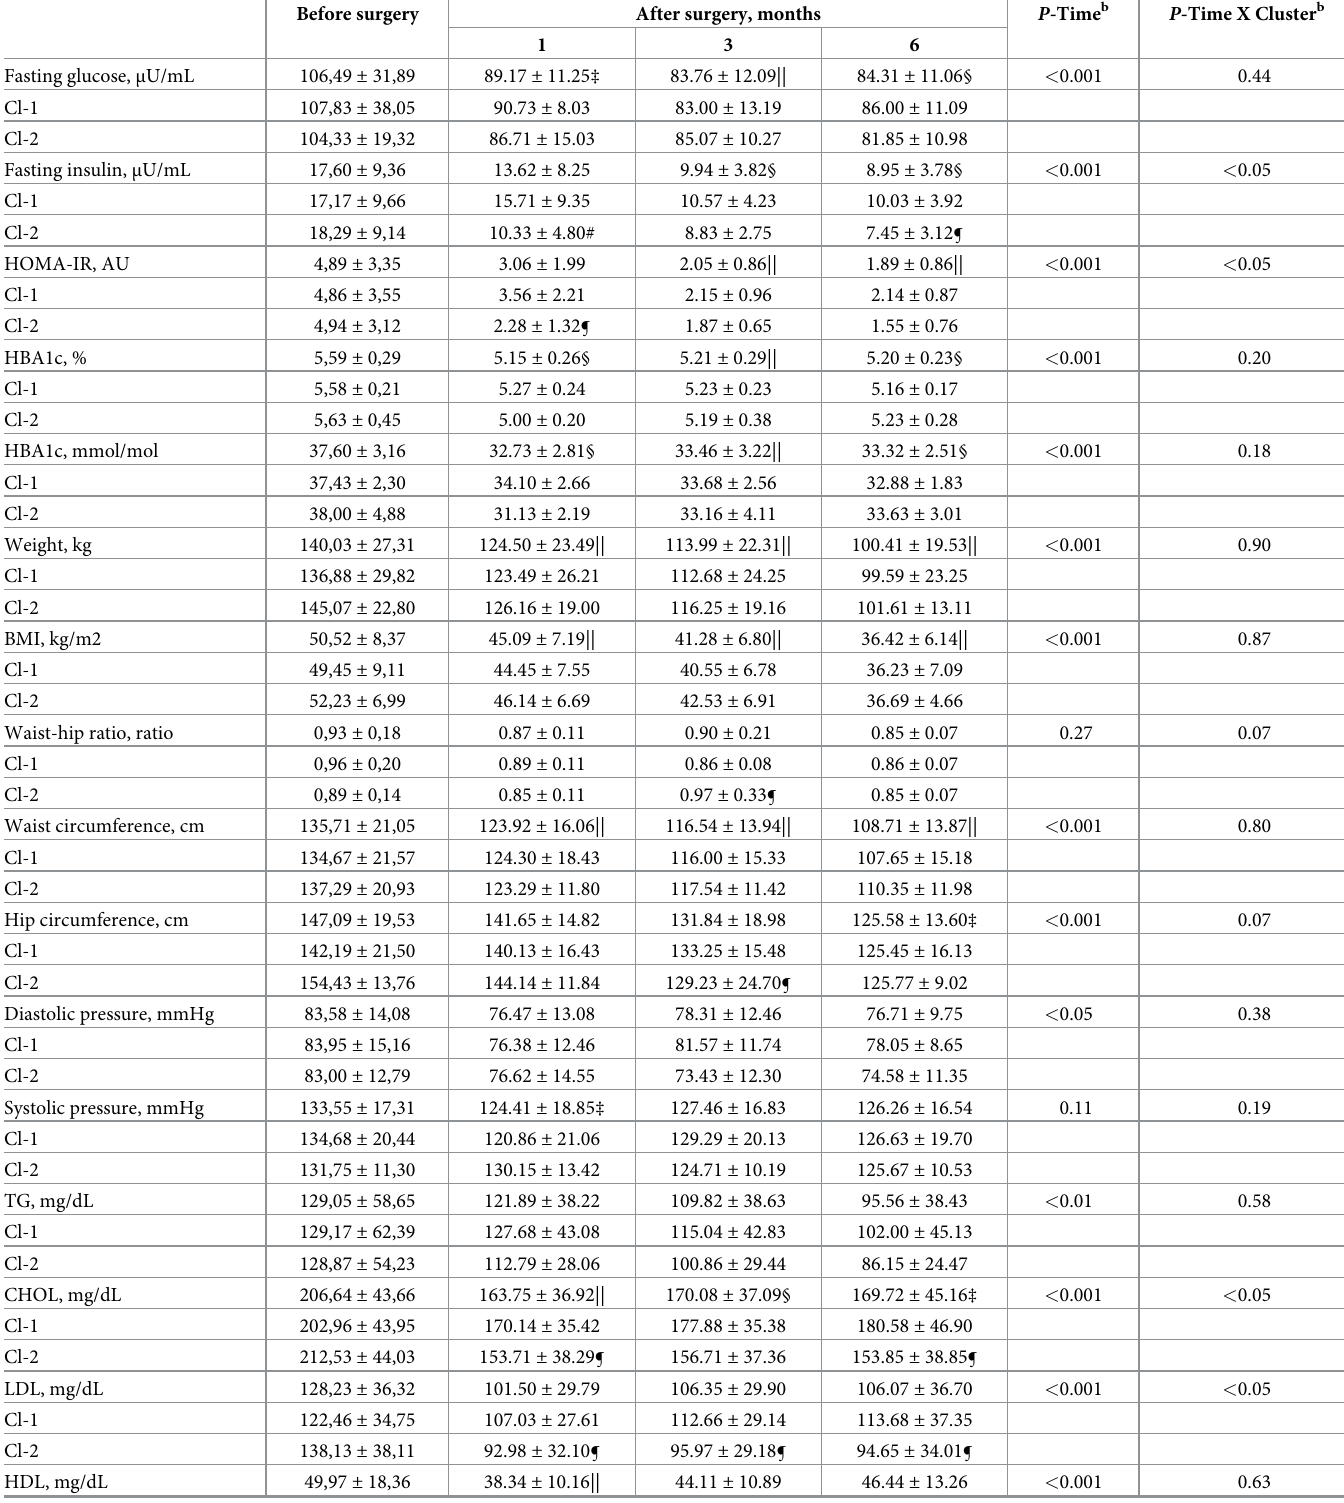
Table 3. Anthropometric and clinical characteristics before bariatric surgery and 1, 3 and 6 months after surgery a . Before surgery After surgery, months P -Time